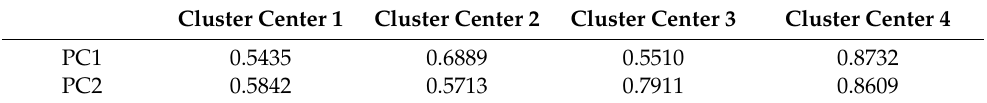
Table 4. Coordinates of four cluster centers.